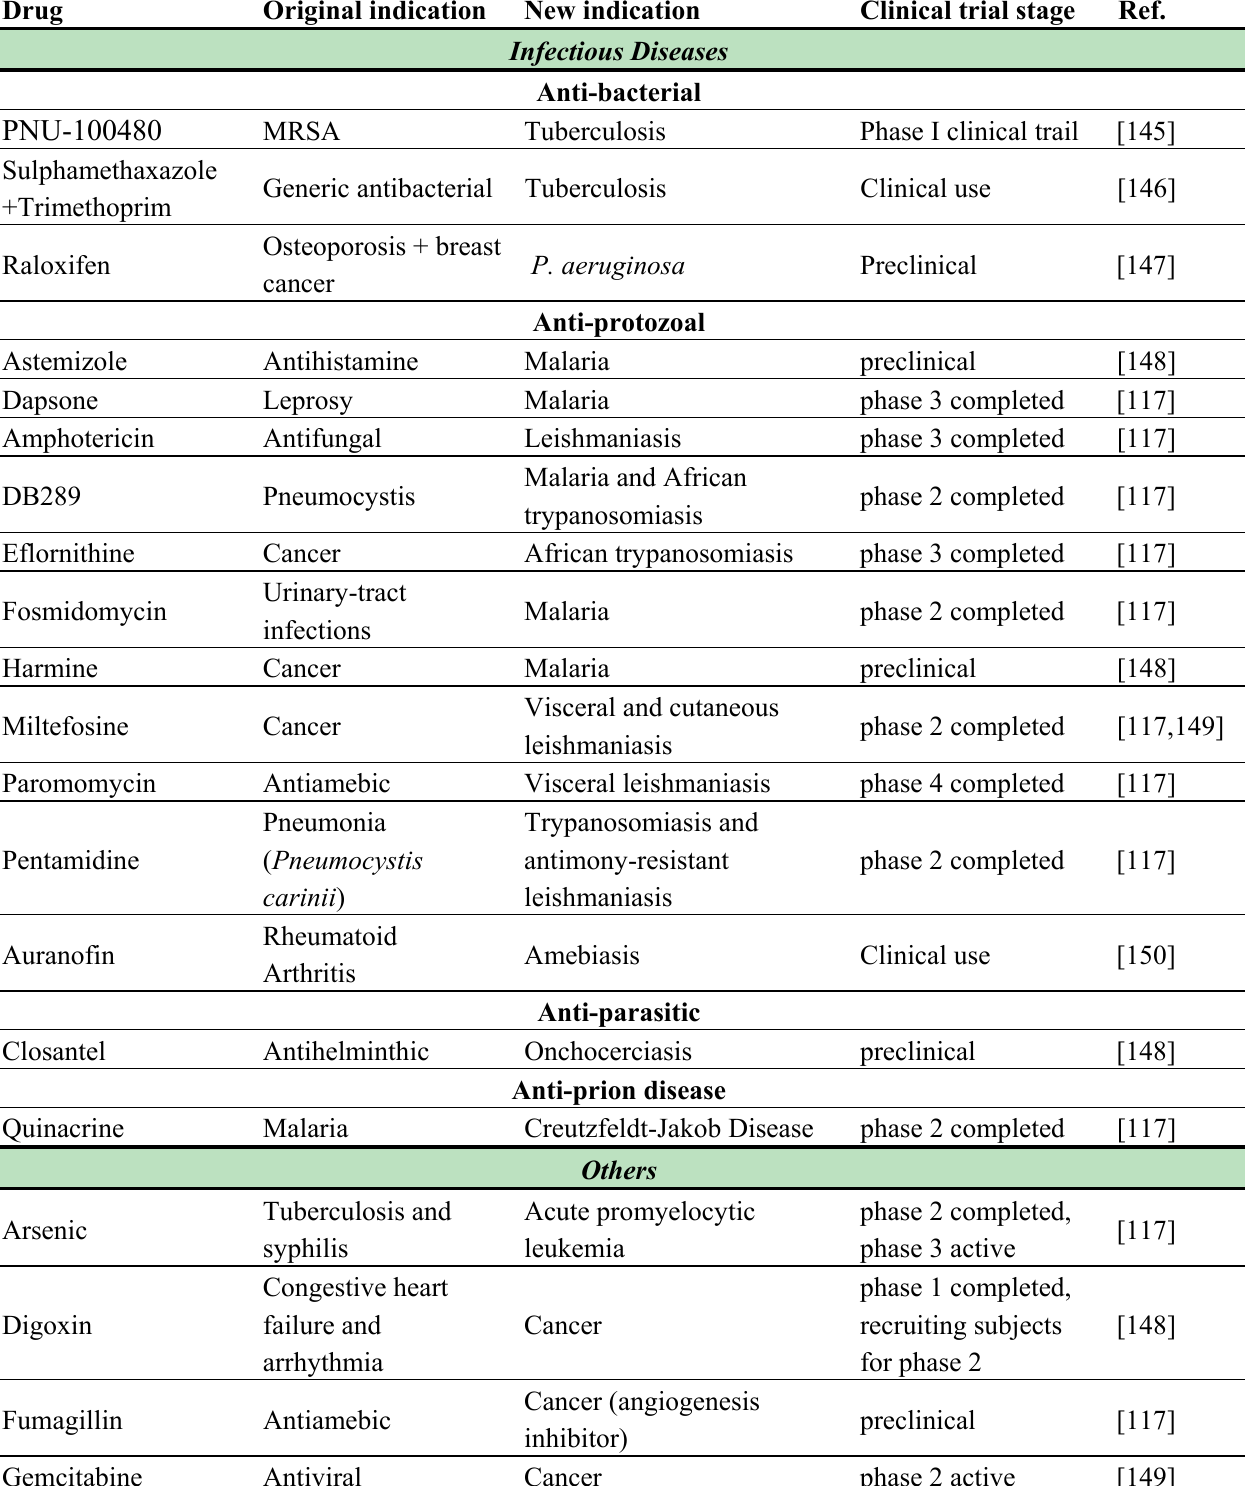
Table 3. List of repositioned drugs currently in different stages of clinical